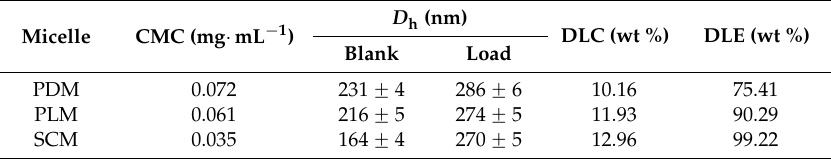
Table 2. Properties of PDM, PLM, and SCM without and with HCPT.